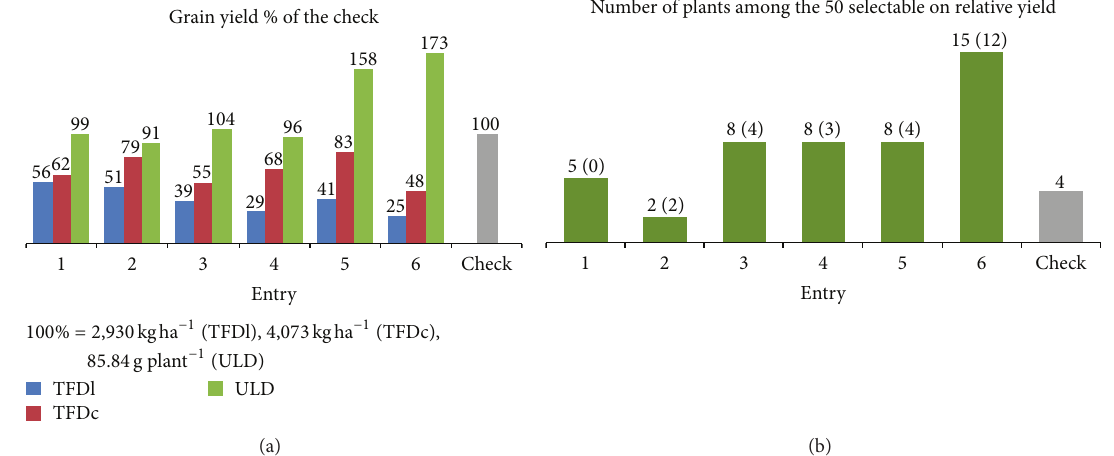
lagged behind the check significantly by 36 up to